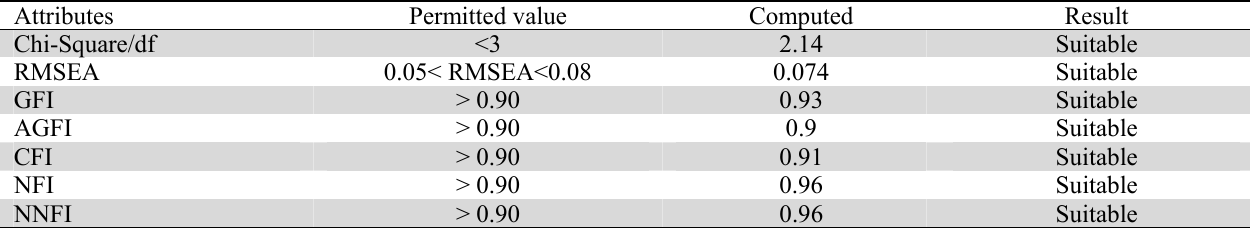
Fig. 3. The results of standard values for SEM implementation The results of statistical observations